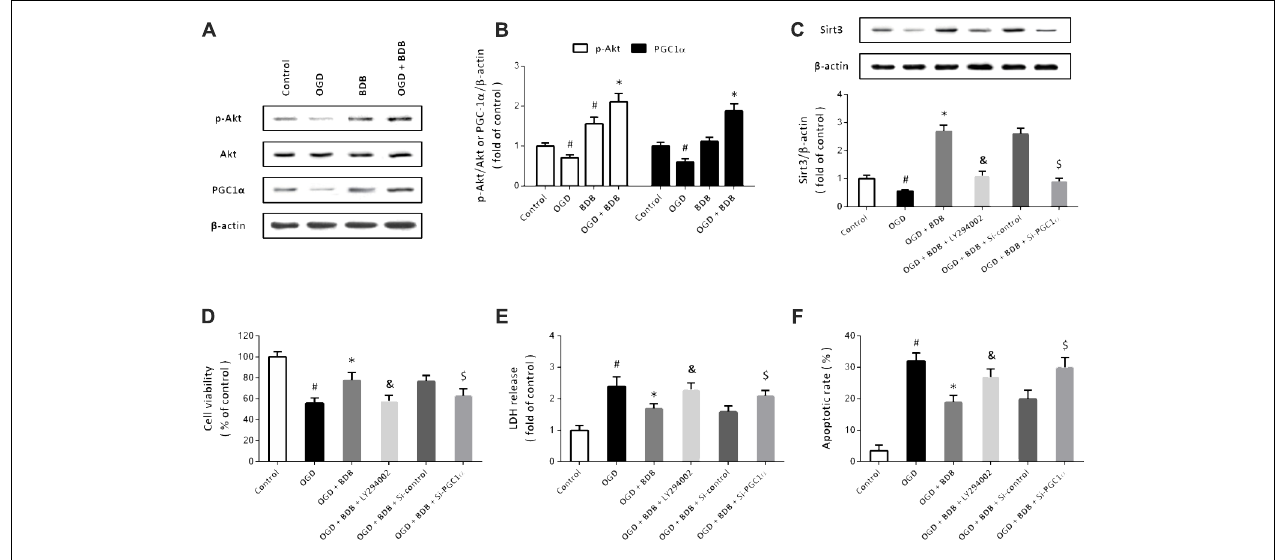
FIGURE 5 | BDB stimulates the Akt-PGC1 α -Sirt3 pathway in cardiomyocytes. (A,B) Western blot (A) and quantification (B) show that BDB increased PGC1 α expression and Akt phosphorylation after OGD. (C) Western blot shows that BDB-induced Sirt3 expression was dependent on Akt and PGC1 α . (D) WST-1 assay shows that BDB-induced increase in cell viability after OGD was dependent on Akt and PGC1 α . (E) LDH release assay shows that BDB-induced decrease in LDH release after OGD was dependent on Akt and PGC1 α . (F) Flow cytometry shows that BDB-induced inhibition in apoptosis after OGD was dependent on Akt and PGC1 α . Data are shown as mean ± SEM ( n = 6). # p < 0.05 vs. Control. ∗ p < 0.05 vs. OGD. & p < 0.05 vs. OGD + BDB. $ p < 0.05 vs. Si-control.